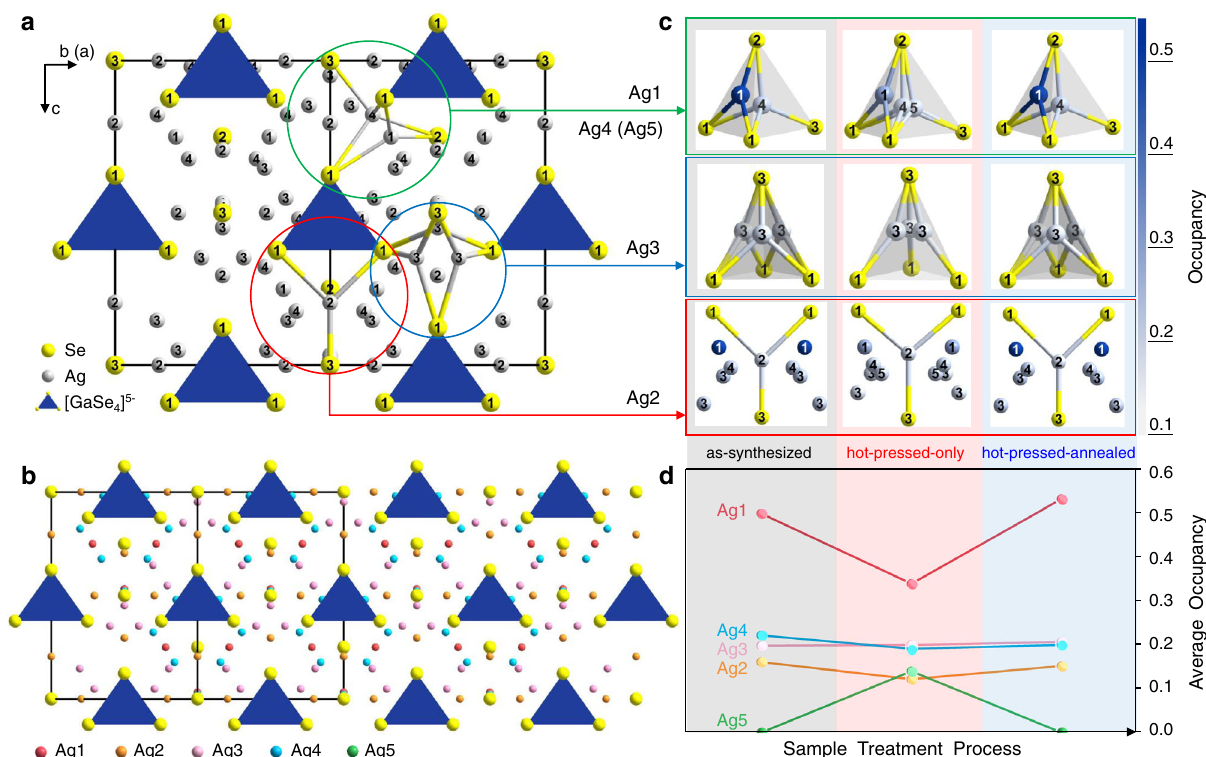
Fig. 5 Single crystal structure of Ag 9 GaSe 6 , with the Ag local coordination environment and site occupancy obtained by the single crystal diffraction data. a The unit cell with atoms numbered. Selected Ag – Se bonds are shown. b Structure view with the unit cell marked. The crystallographic independent Ag atoms are marked by different colors. c The Ag local coordination of all crystallographic independent Ag1 – 5 atoms in a unit cell. The right-side color code indicates the Ag site occupancy. d The occupancy change as a function of the sample treatment. Each average occupancy is obtained by the arithmetic average of those re fi ned by 9 different single crystals selected from each batch of the samples. Detailed crystallographic data, re fi nements, atomic coordinates, anisotropic displacement parameters and occupancies are listed in Supplementary Tables 1 – 12 in the Supplementary Information.